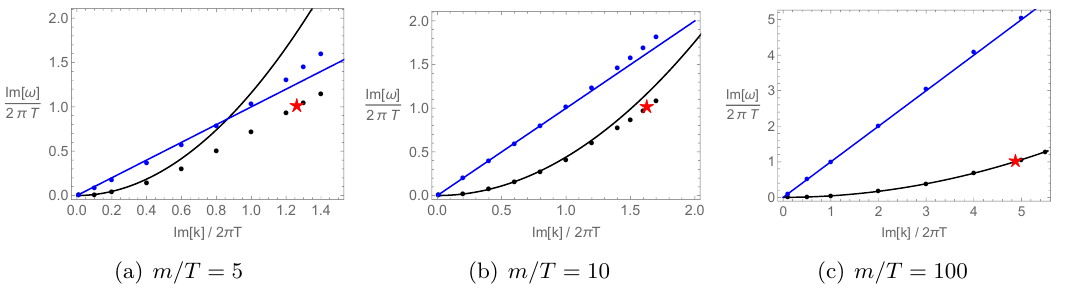
Figure 5 . Pole-skipping and quasi-normal modes in the SSB case with varying m/T . In all figures, dots are numerically computed quasi-normal modes, the red star is the pole-skipping point (2.14), the black solid line is the crystal diffusion mode in (3.27), and the blue solid line is the longitudinal sound mode